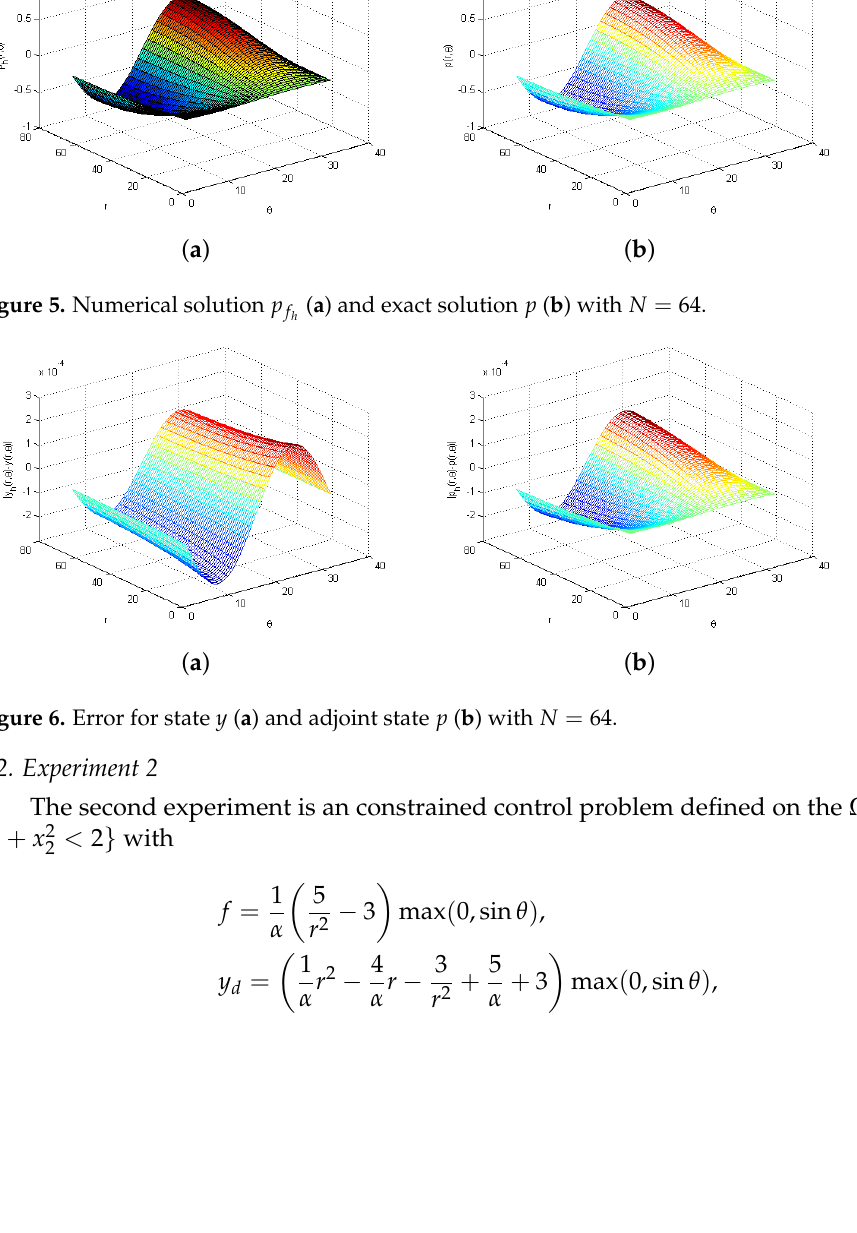
( a ) and exact solution y ( b ) with N = 64. h